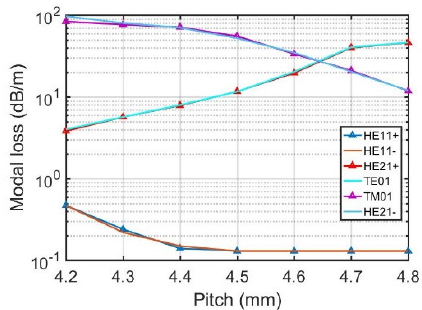
Figure 9. Modal losses of a twisted heptagon-shaped core fiber versus Λ with R = 25 μm, NA = 0.065, and λ = 1064 nm, Λ in the range of 4.2–4.8 mm.